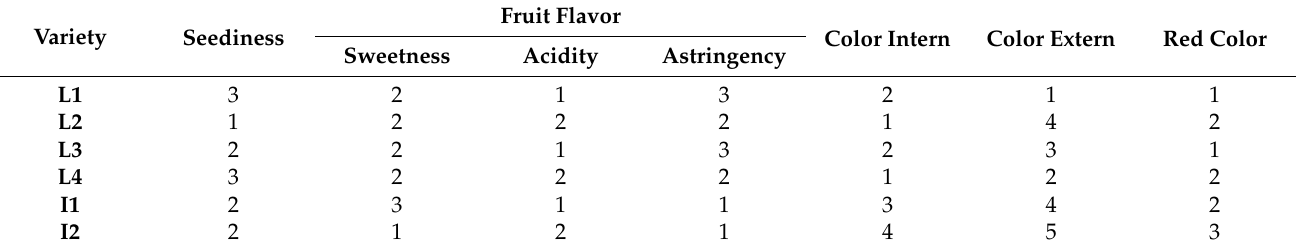
Table 3. Some organoleptic properties of PJ